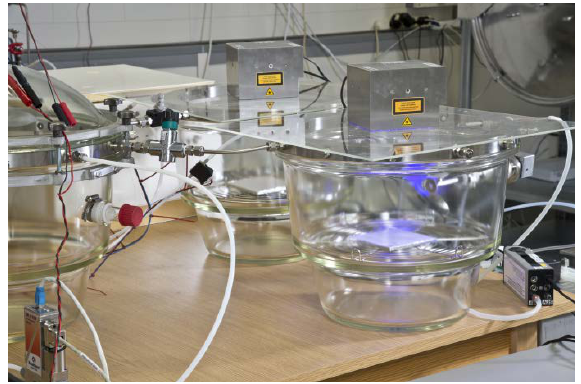
Figure 2. Experimental setup of the gas mixing chamber with two connected 20 L emission test chambers. Both chambers are equipped with ceramic tiles and one is irradiated with UV light.